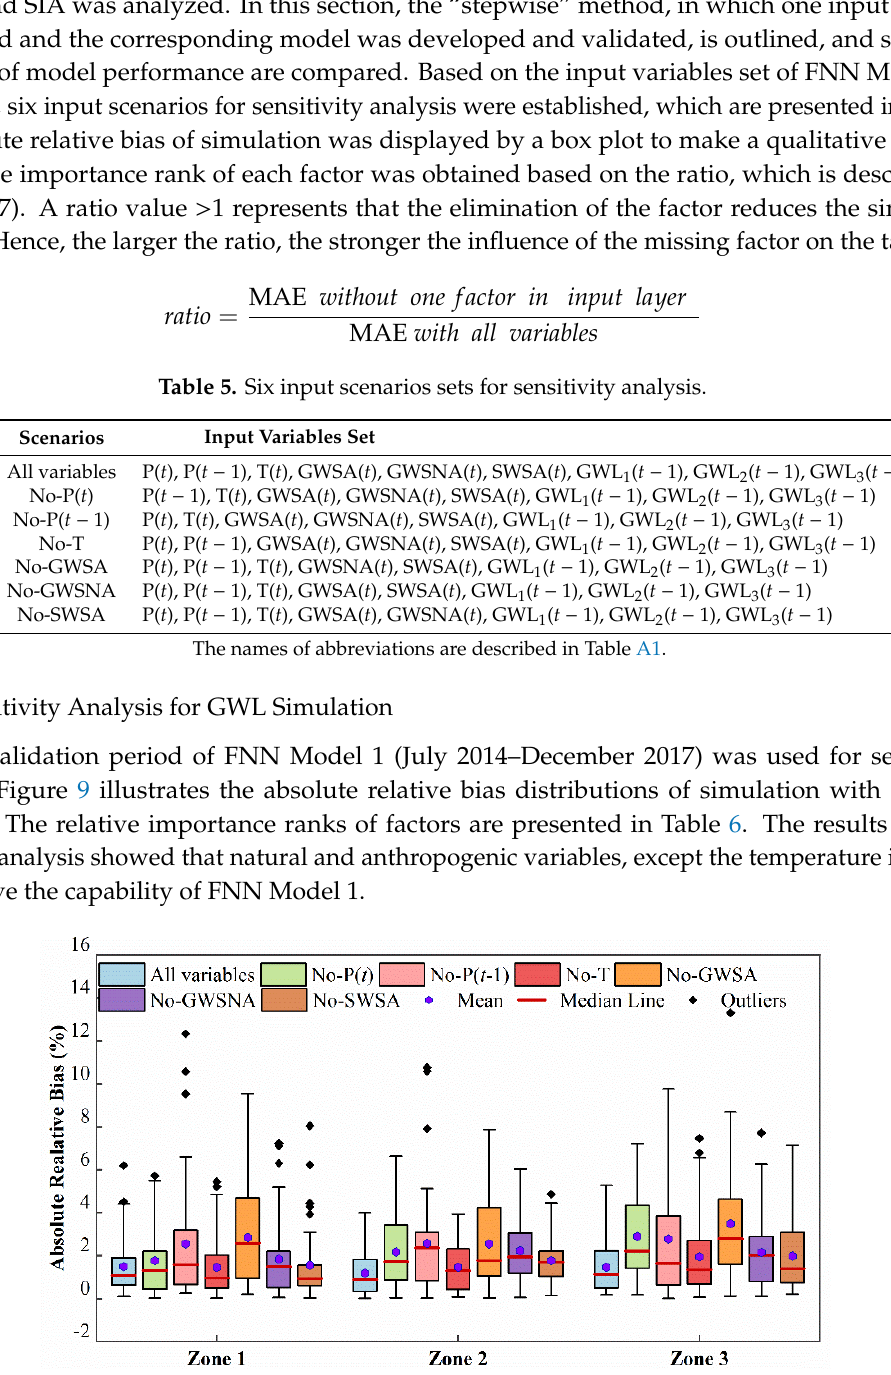
Figure 9. Box plot of absolute relative bias distributions of GWL simulation with different input variables sets in Zone1, Zone2, and Zone3. The ends of boxes represent the first and third quartiles, and the whiskers represent the values at 1.5 standard deviations. Table 6. The sensitivity analysis results of impact factors for monthly average GWL.